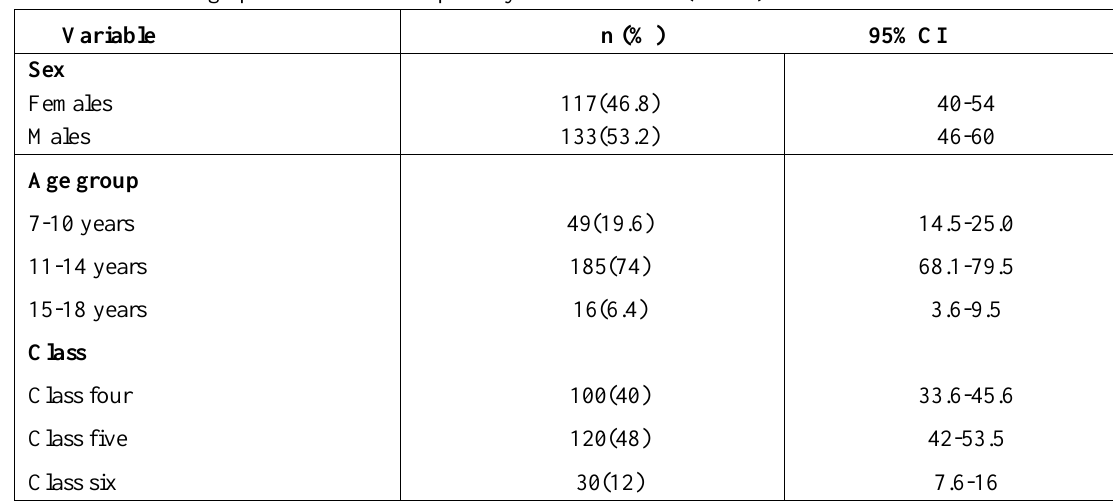
Table 1. Social-demographic characteristics primary school children